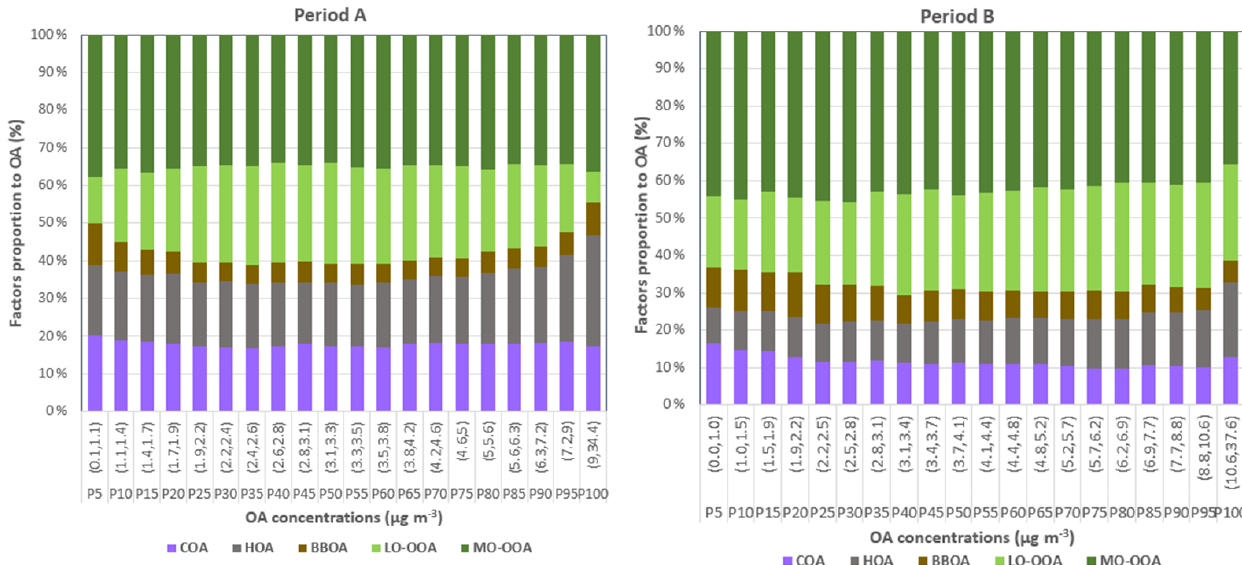
Figure 6. Relative contribution of organic sources as a function of OA concentrations. Ranges in brackets on the x axis represent the range of OA concentrations for which the relative contribution is shown in each of the bins. The OA concentration bins are determined corresponding to intervals of 5 points in the percentiles, starting with P0–P5, and increasing as shown by the percentile P x specified below the